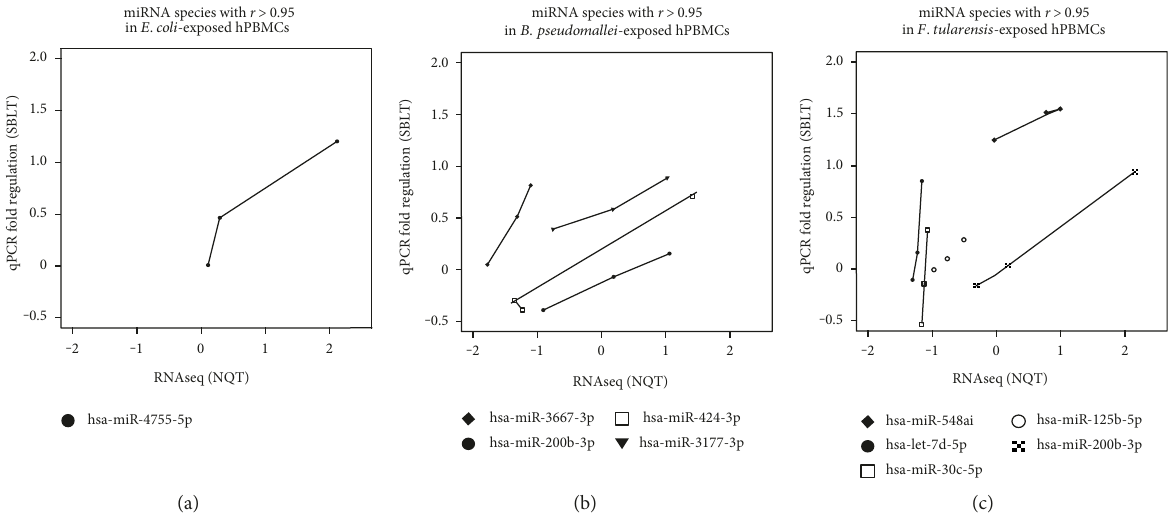
Figure 4: A subset of miRNA species with r > 0 95 between RNAseq (NQT) and qPCR (SBLT) fold changes. (a) E. coli -exposed hPBMCs: hsa-miR-4755 ( P = 0 1973 ); (b) B. pseudomallei -exposed hPBMCs: hsa-miR-3177-3p, hsa-miR-200b-3p ( P = 0 0275 ), hsa-miR-3667-3p ( P = 0 0602 ), and hsa-miR-424-3p ( P = 0 0670 ); (c) F. tularensis -exposed hPBMCs: hsa-miR-200b-3p ( P = 0 0160 ), hsa-miR-548ai ( P = 0 0489 ), hsa-miR-125b-5p ( P = 0 0638 ), hsa-let-7d-5p ( P = 0 1788 ), and hsa-miR-30c-5p ( P = 0 0274 ). Table 3: Multiple testing of P values for the 10 miRNAs which had correlation coe ffi cient > 0.95 between RNAseq and